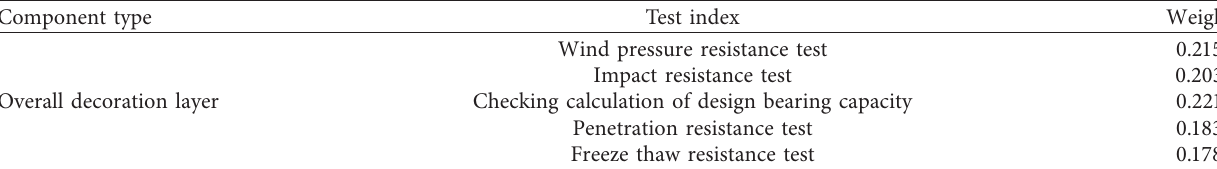
Table 10: Test index of bearing capacity of the building finish layer.